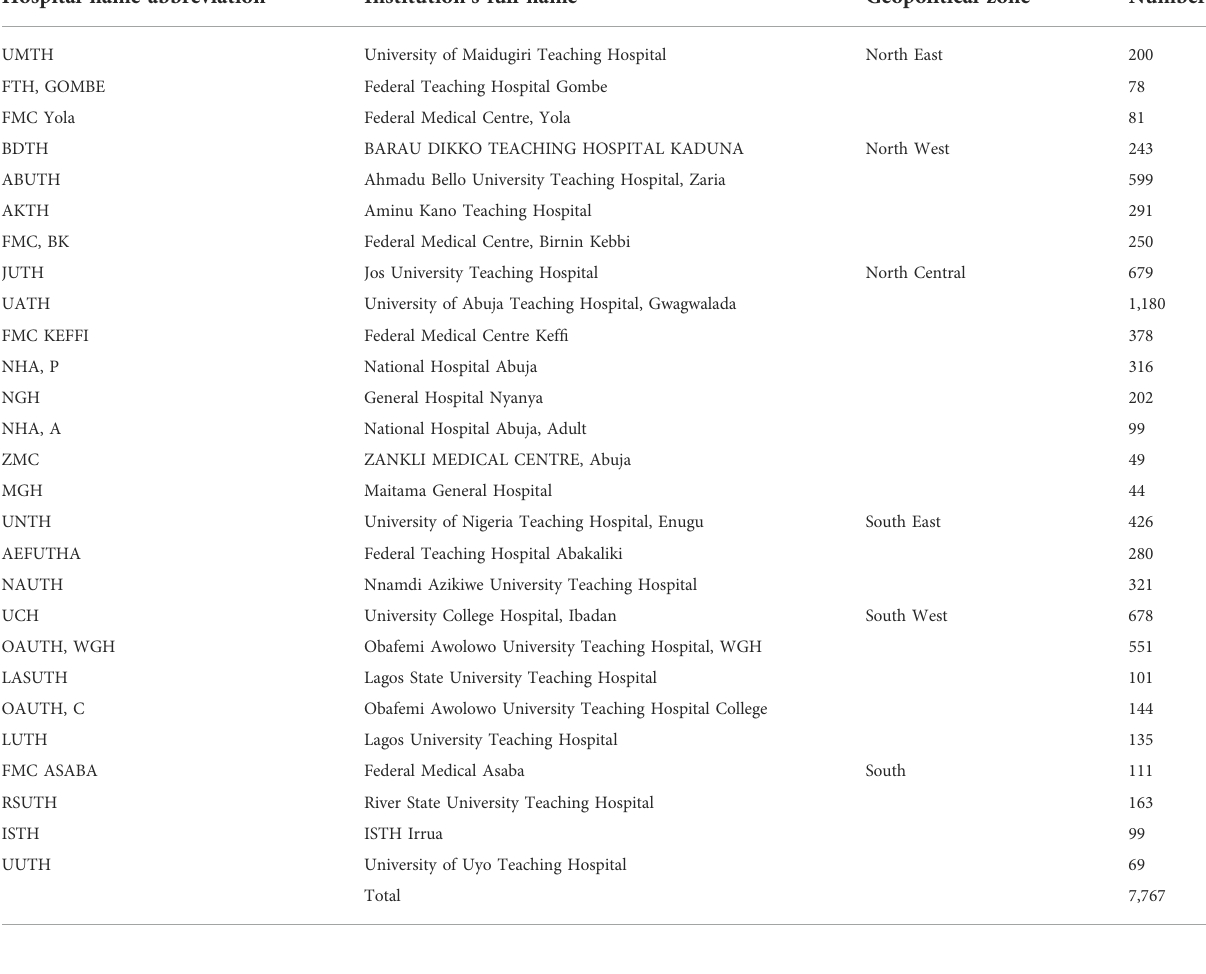
TABLE 1 Enrolment by SPARCO centers across Nigeria.